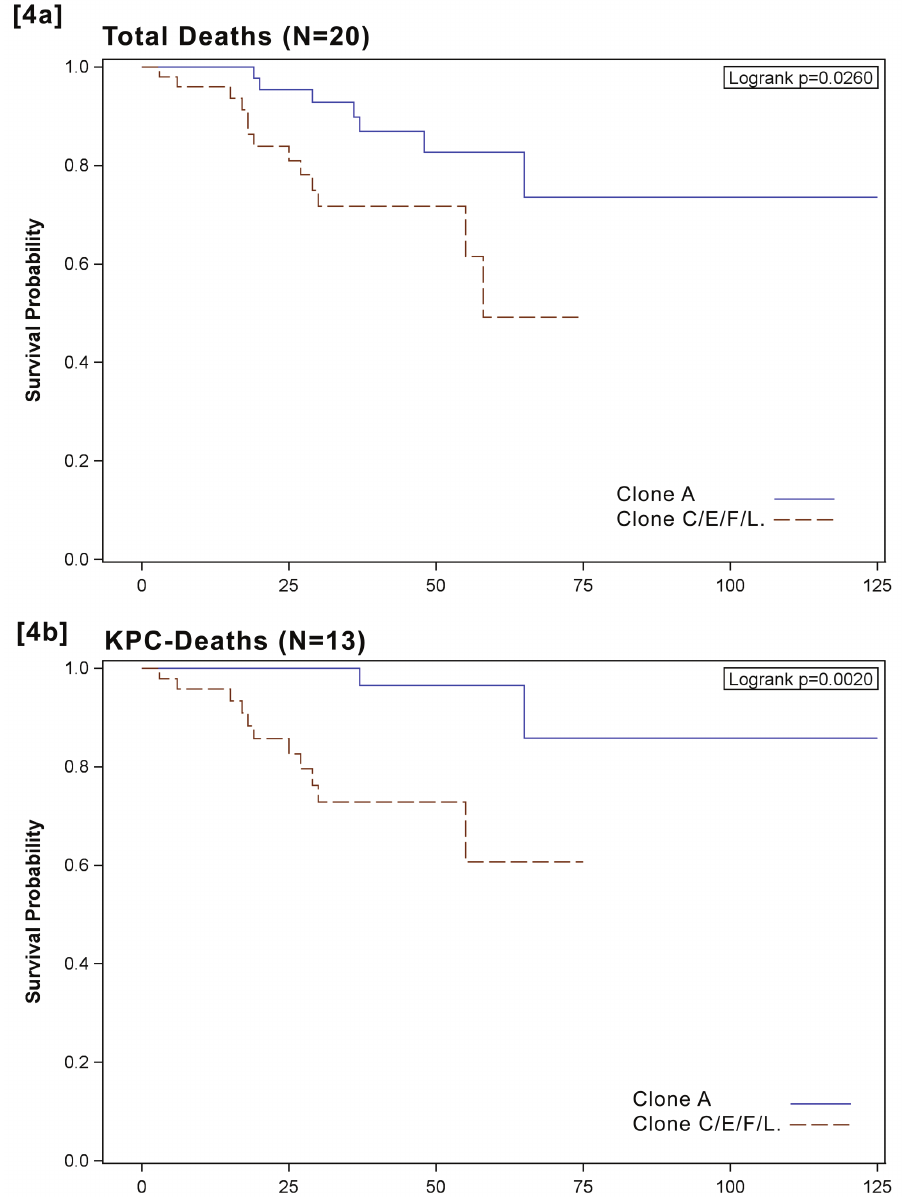
Figure 4. Kaplan-Meier curves showing the impact of KPC-clones (C/E/F/L: red line) versus clone A (blue line) on 30-days mortality of patients with KPC infection. Figure 2A: overall mortality, Figure 2B: KPC-re- lated